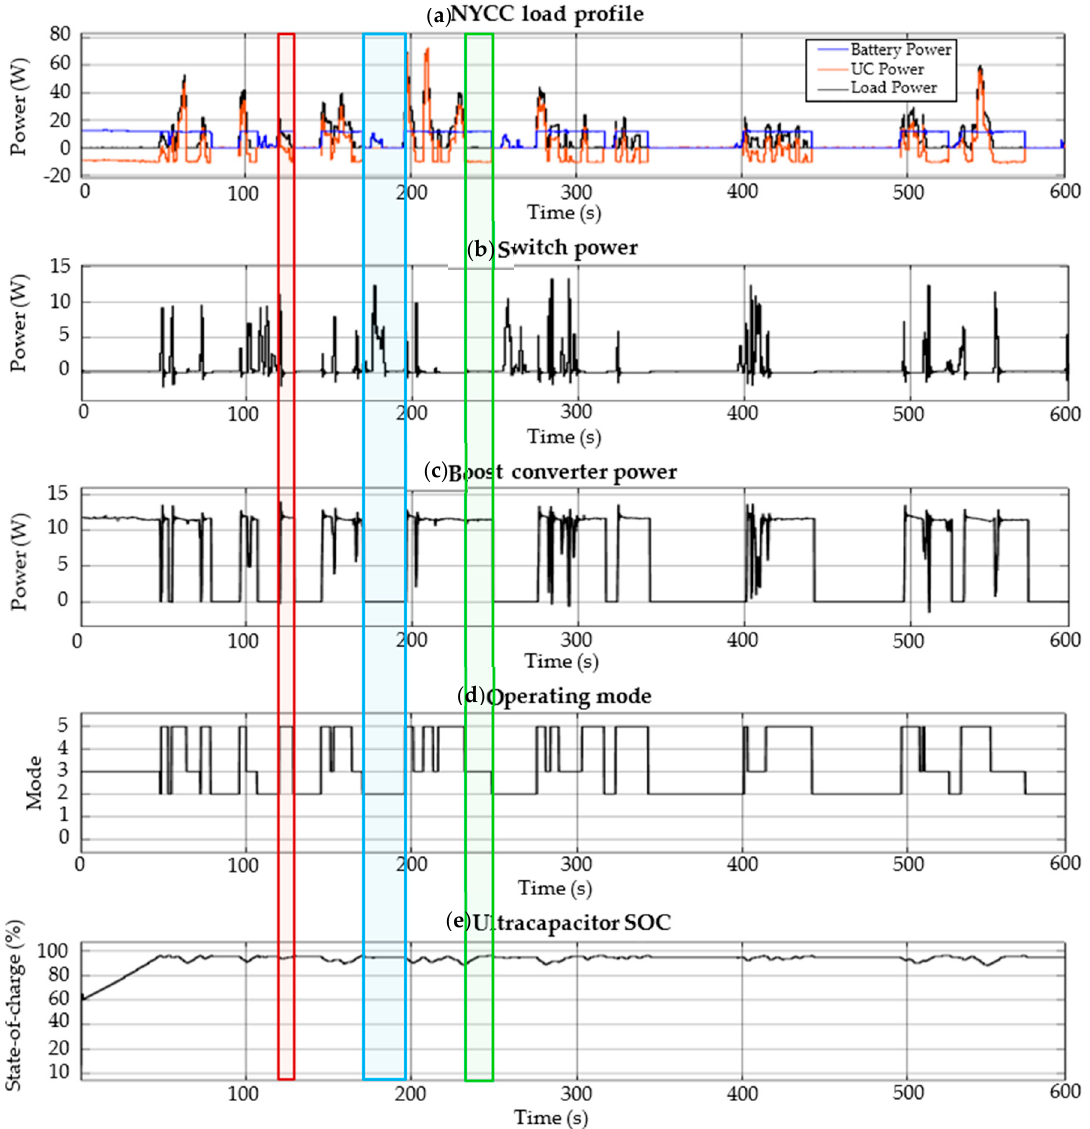
Figure 17. ( a ) WLTC Class 2 power distribution; ( b ) Power through the switch; ( c ) Power transferred through the boost converter; ( d ) Controller operating mode; ( e ) UC state-of-charge.